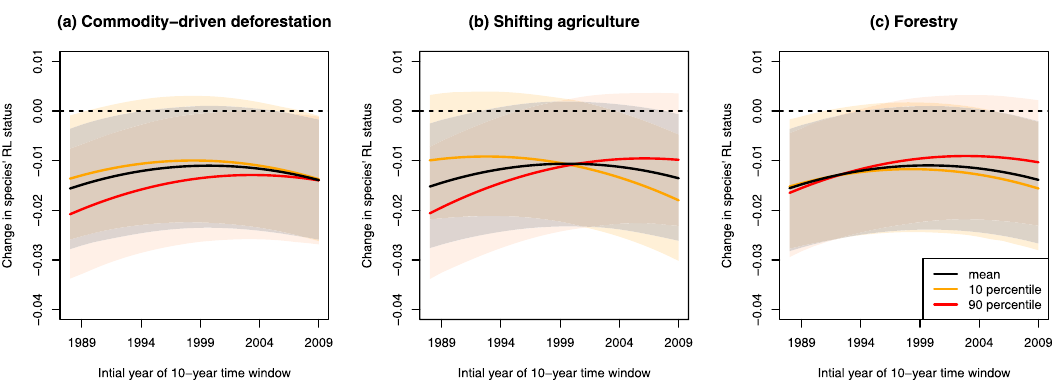
Fig. 4 Temporal trends of IUCN Red List status in tropical subregions (South-East Asia, Africa, and Latin America) interacting with the proportion of focal current forest disturbance driver. a commodity-driven deforestation, b shifting agriculture, and c forestry. The change in species ’ Red List status was measured as a mean status change within a 10-year window sequentially moved to cover 1988 – 2018. Positive and a negative changes represent improving and worsening of the status, respectively. Black, orange, and red solid lines represent status change predicted by a generalized linear mixed model (GLMM; see Methods for details) when proportion of focal disturbance driver was assumed to be mean, 10th percentile, and 90th percentile of observed proportions, respectively, keeping all other drivers at the mean level. Each polygon represents a 90% prediction interval based on fi xed effects of the GLMM, and the color of each polygon corresponds to the prediction shown as a solid